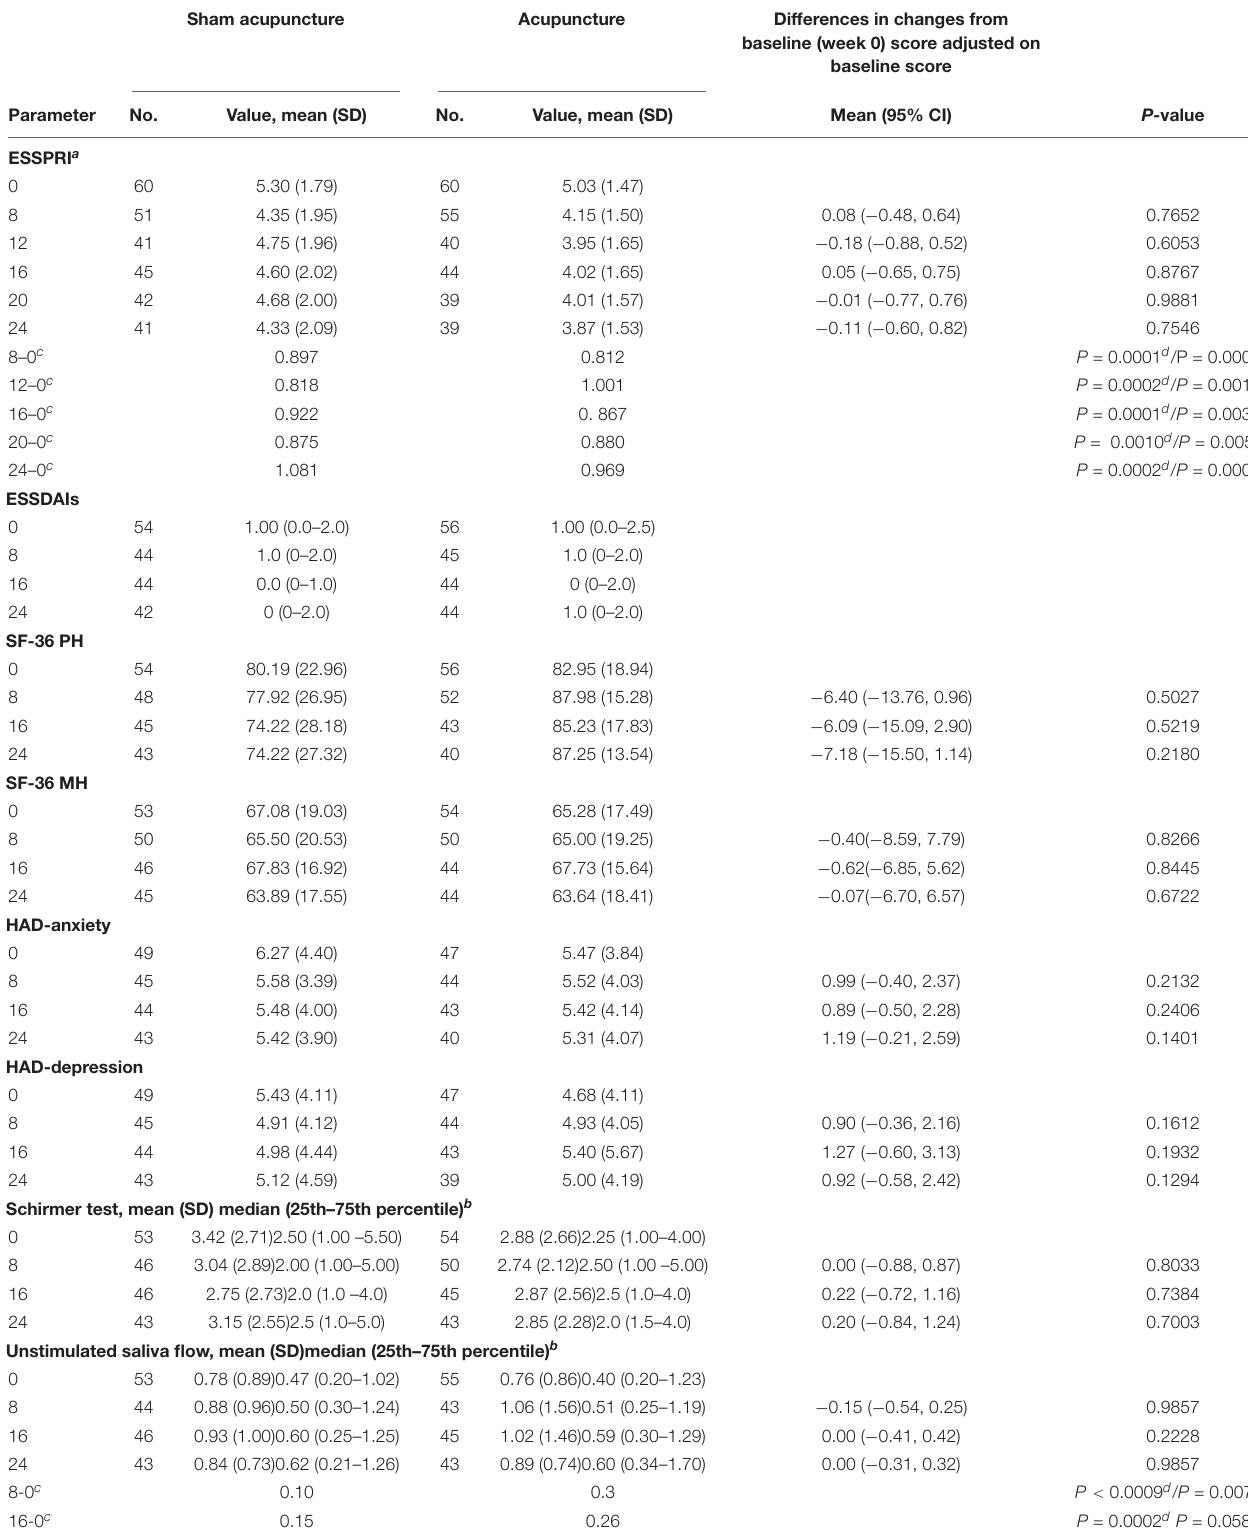
TABLE 6 | ESSPRI, ESSDAI, evaluation of disease activity by practitioner, patient-related outcome, and biological variables, by group. Sham acupuncture Acupuncture Differences in changes from baseline (week 0) score adjusted on baseline